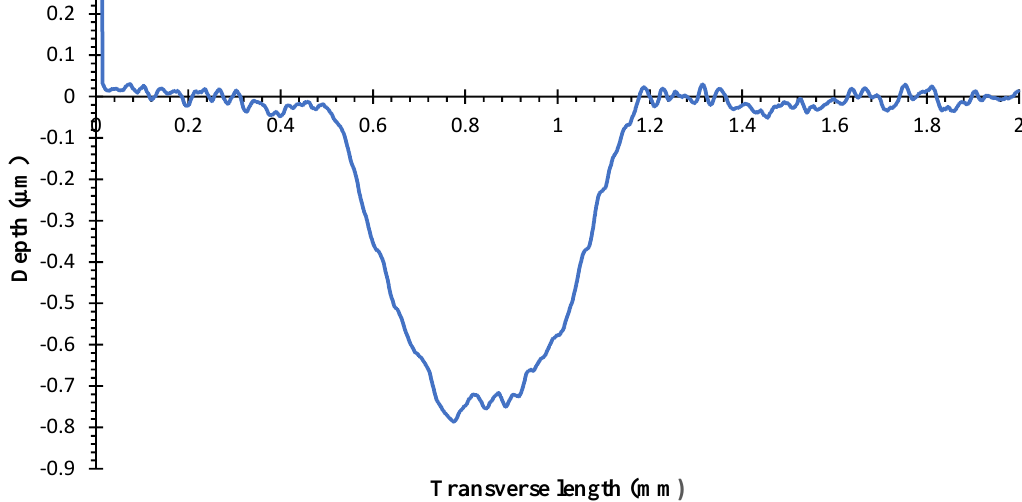
Figure A1. Example of cross-section 2D profile of a levelled and smoothed wear track.